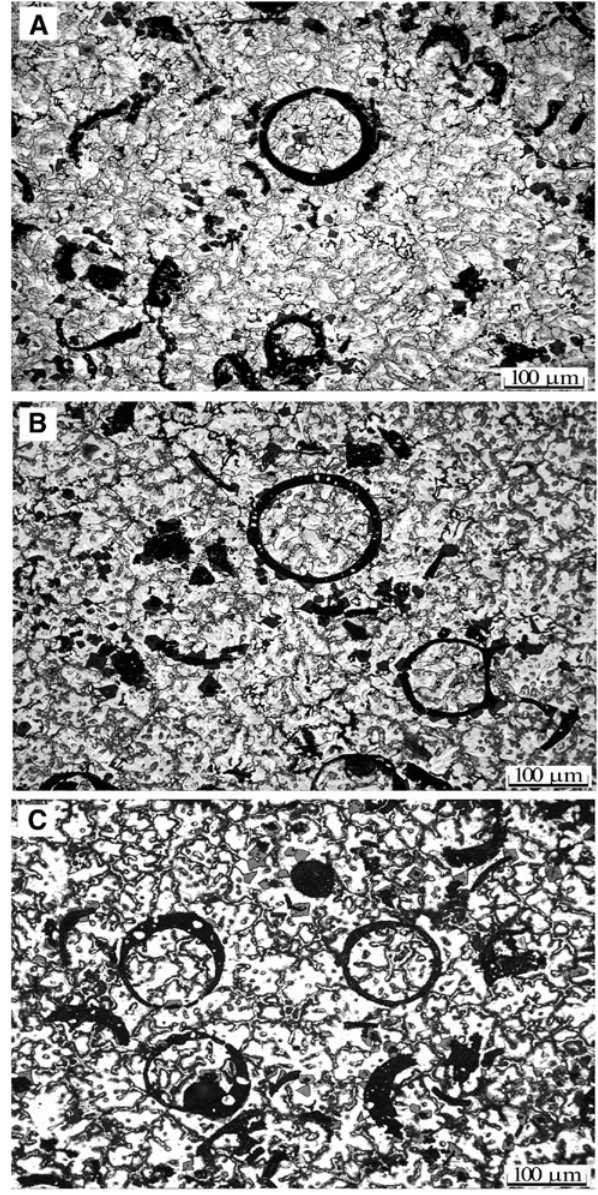
Figure 4: Microstructures of 6 wt.% FAC/AZ91D composites after heat treatment at different temperatures: (A) 100 ° C, (B) 150 ° C, and (C) 200 °